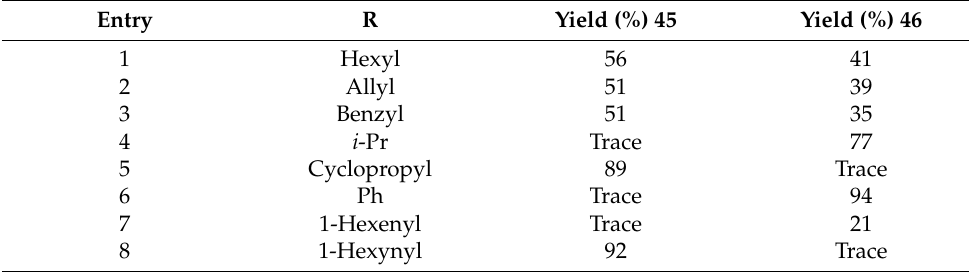
Table 16. Scope of homologation reactions involving 9-BBN derivatives (Scheme